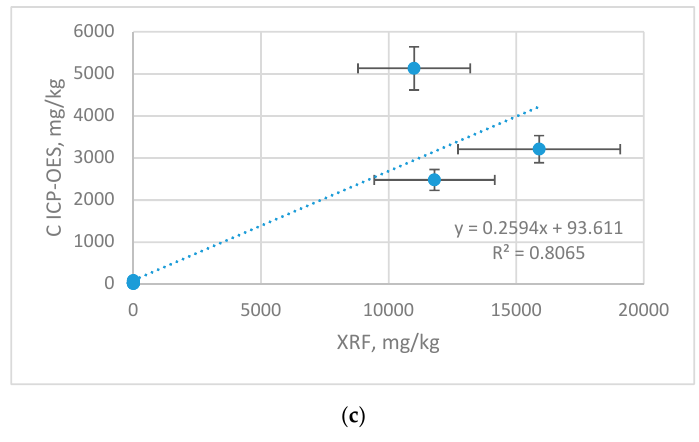
Figure 3. Correlation between XRF and ICP-OES results ( a ) Cu; ( b ) Zn; ( c ) Mn.